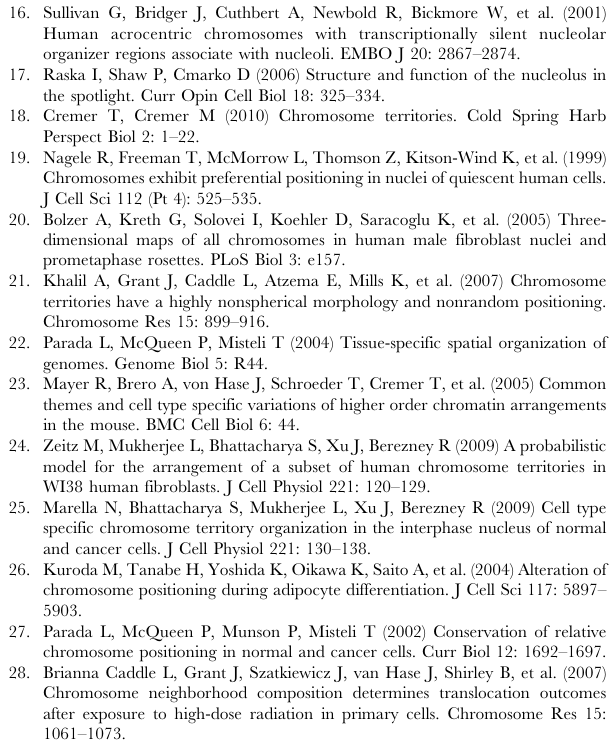
and 10A S ( H ). Each cell in the matrix represents the percent of input nuclei that have an interaction between those homologs. Values are color-coded on a color-scale from low (red) to high (green). Table S1 Chi-square values comparing the overall patterns to uniform averages. The overall patterns were compared to their uniform averages. Chi-square p values are shown for experimental and random simulations. Green p , 0.05, yellow p , 0.01, red p , 0.001. Table S2 Chi-square values comparing the overall patterns between G1 and S. The chi-square p values are shown comparing the overall patterns in G1 to S in 10A to WI38 and in random simulations for G1 versus S. Green p , 0.05, yellow p , 0.01, red p , 0.001. Table S3 Chi-square values of individual CT pairs across the cell cycle. The chi-square p values are shown comparing G1 to S for each individual CT pair in WI38 and in 10A for differences in the percent of cells with only 1 interaction, $ 2 interactions, and when considering both = 1 $ 2 interactions together. Purple p , 0.10, Green p , 0.05, yellow p , 0.01, red p , 0.001. Table S4 Homologous versus heterologous Interac- tions. The percent of total interactions for heterologous (4